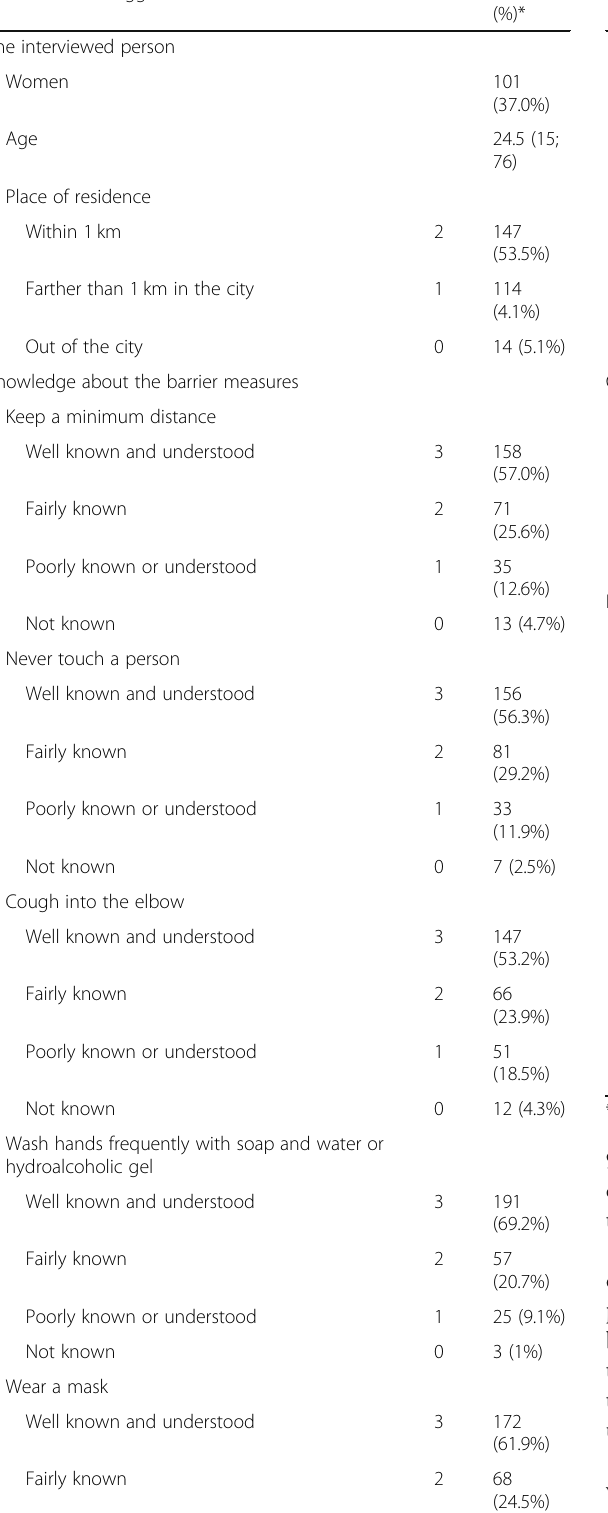
Table 1 Content of the questionnaire given to passers-by in the streets of Bukavu, DRC, May 2020 Questions and suggested answers